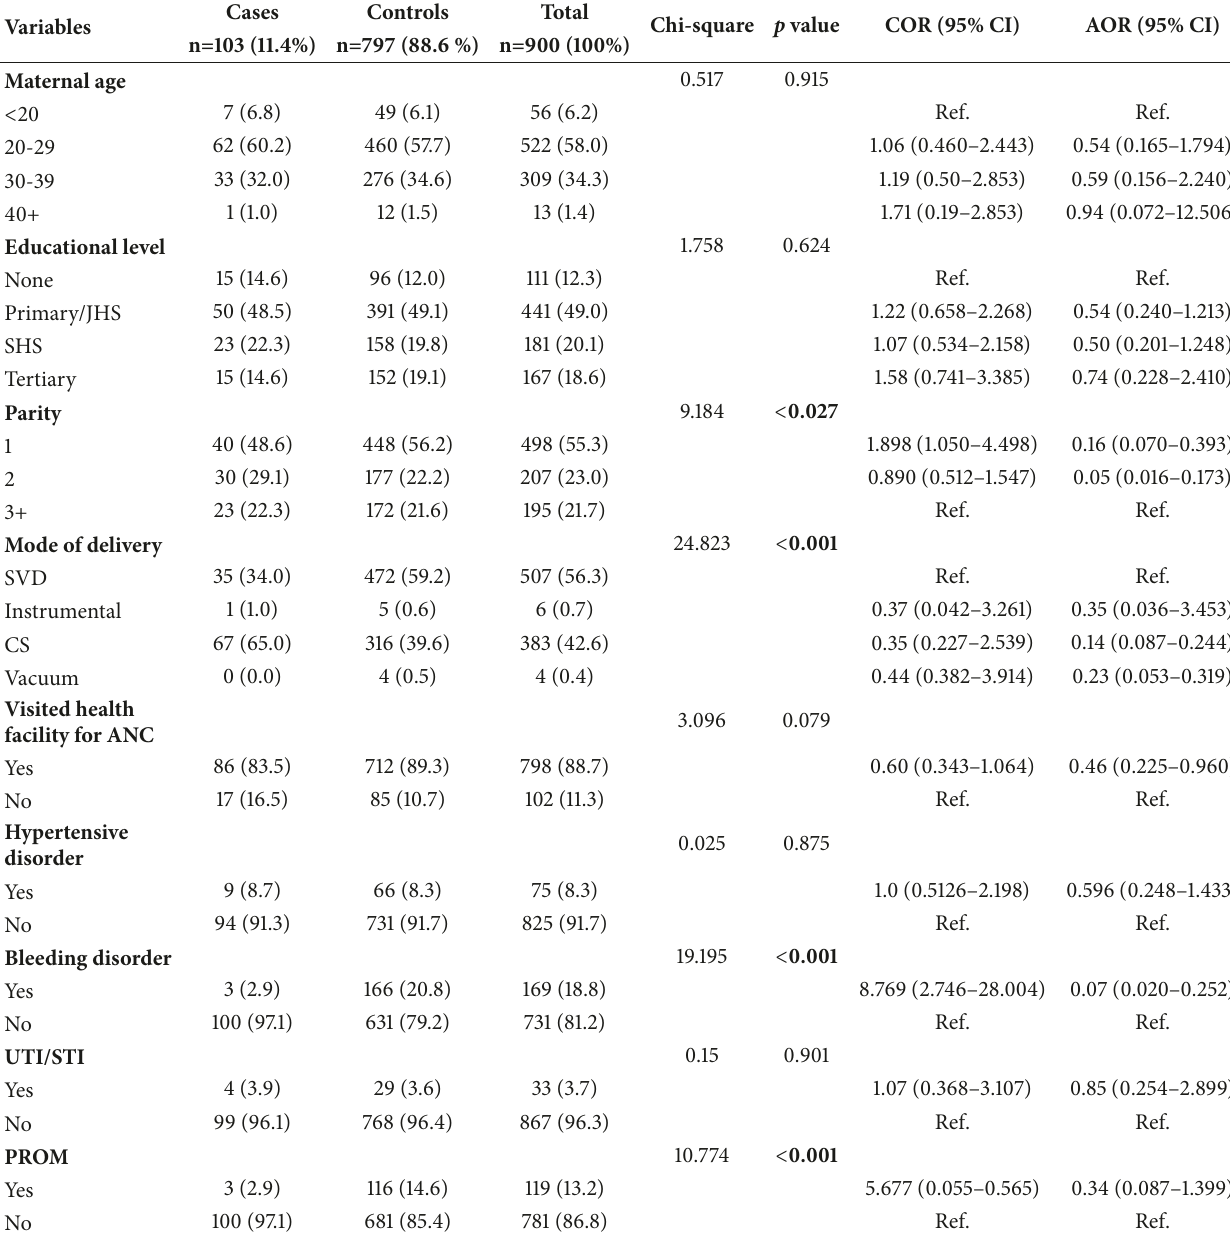
Table 2: Bivariate and multivariate logistic regression analysis of maternal risk factors of neonatal